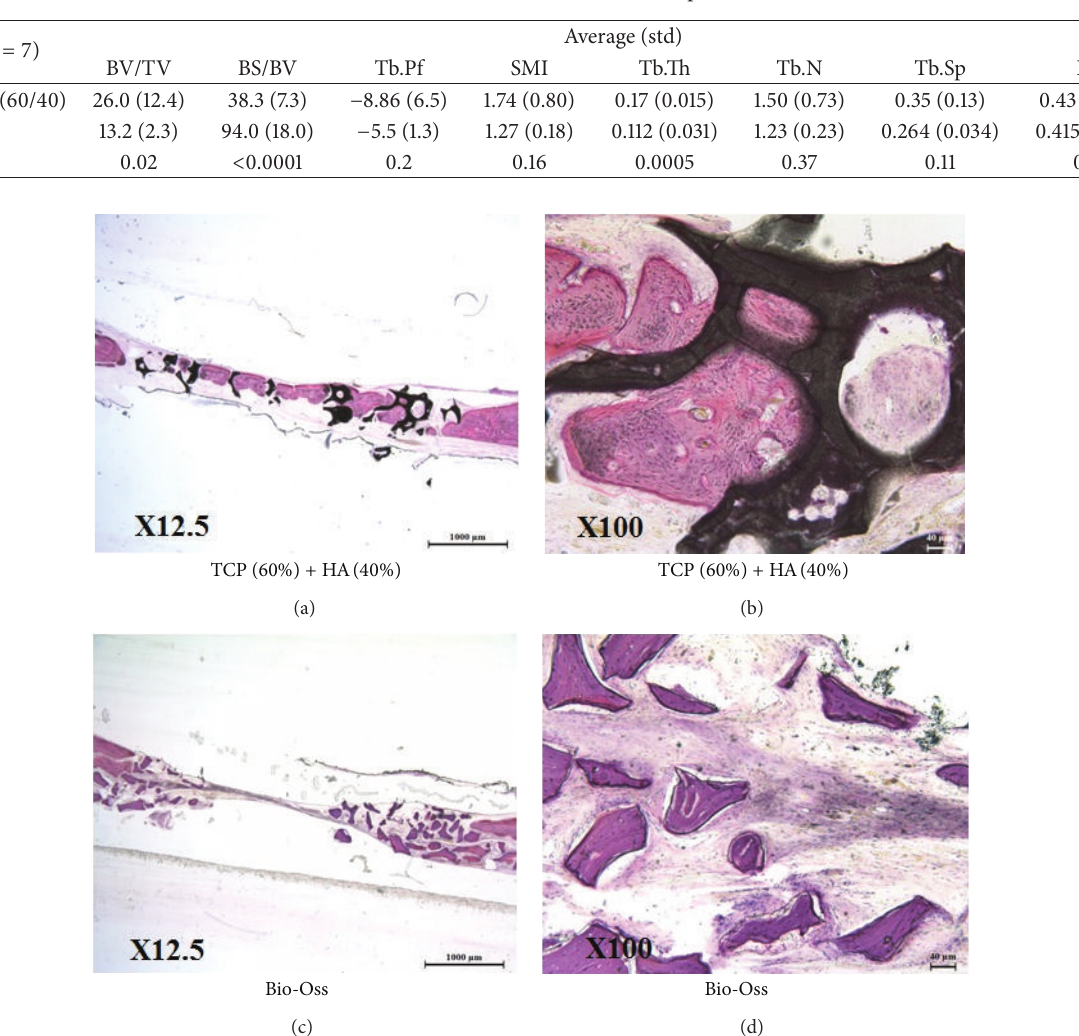
Figure 8: Undecalcified histology of 60TCP40HA and Bio-Oss 8 weeks after